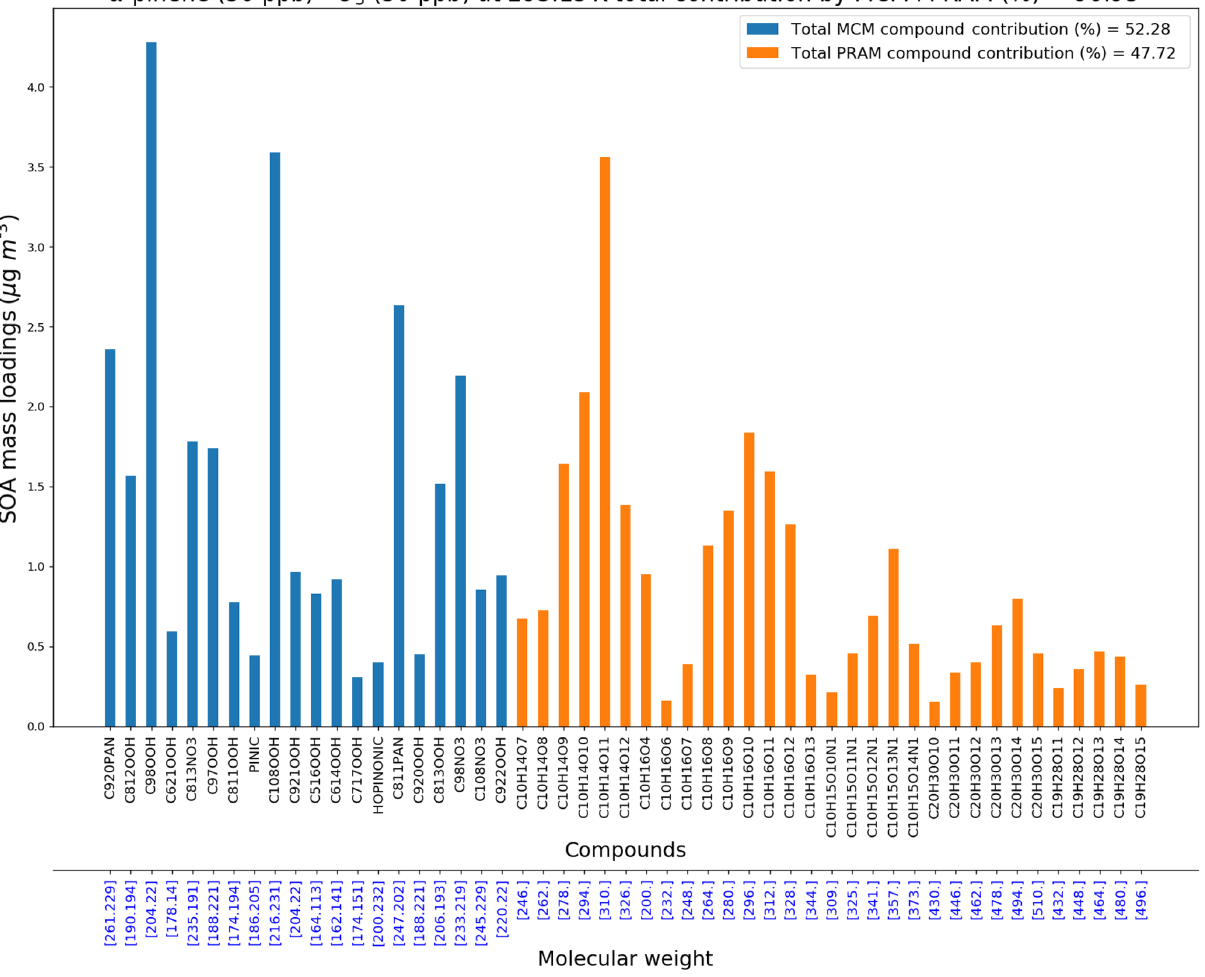
Figure 10. MCM and PRAM compounds contributing to > 95% of SOA mass at 293K and 50ppb O 3 and α -pinene